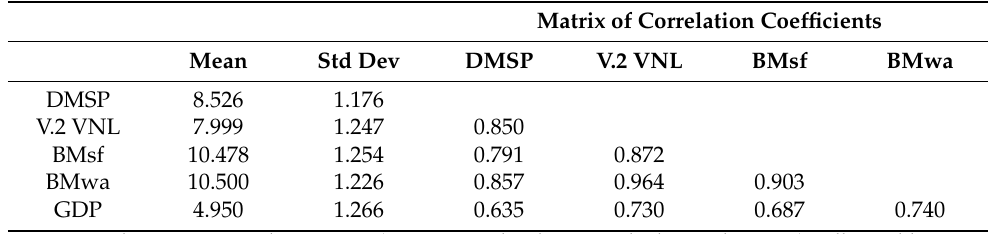
Table 2. Descriptive statistics and correlation coefficients.